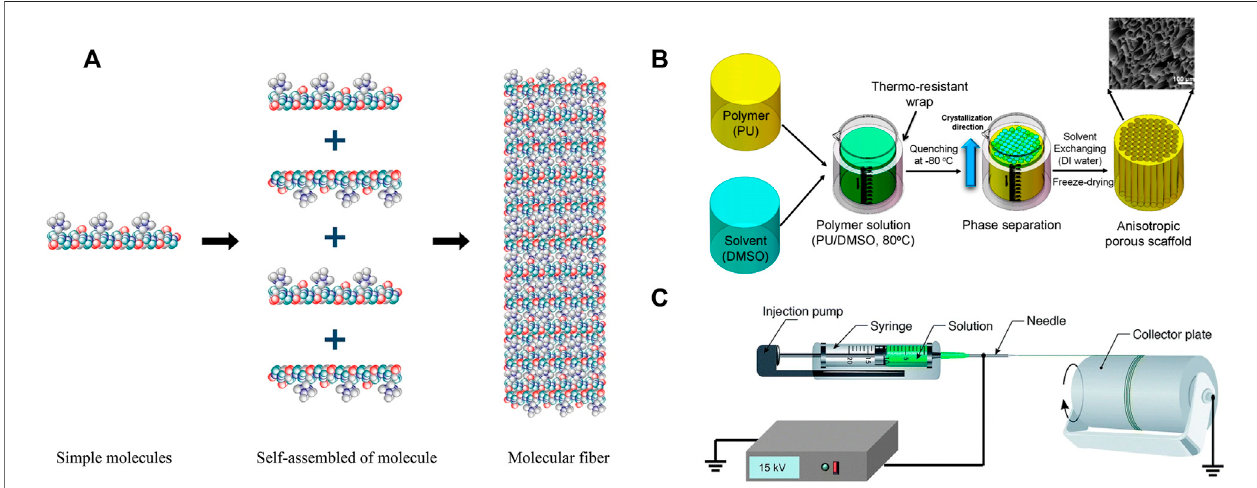
FIGURE 3 | Schematization representation of the nano fi ber manufacturing technology. (A) Self-assembly. Permission to reproduce was granted under the conditions of the license (CC BY 4.0). Copyright 2019, Nemati et al. (2019). (B) Thermal phase separation for the preparation of anisotropic polyurethane porous nano- scaffolds. Permission to reproduce was granted underthe conditionsofthe license (CC BY 4.0). Copyright 2018,Zeinaliet al. (2021). (C) Electrospinning. Permission to reproduce was granted under the conditions of the license (CC BY 4.0). Copyright 2019, Nemati et al. (2019).